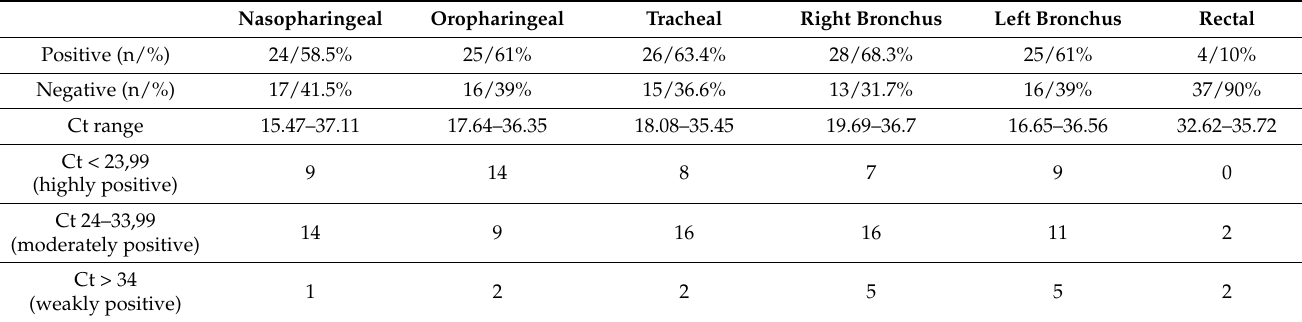
Table 3. Distribution of swab results and Ct